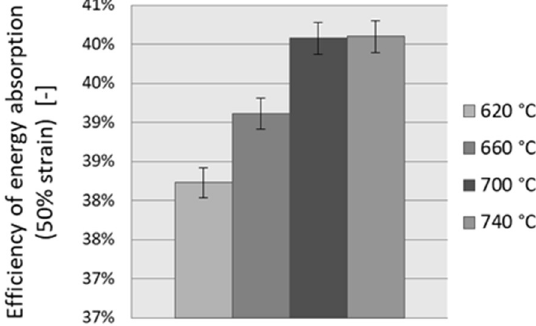
Figure 9. Efficiency of energy absorption for 50% strain for Al-foams with various sintering temperatures.